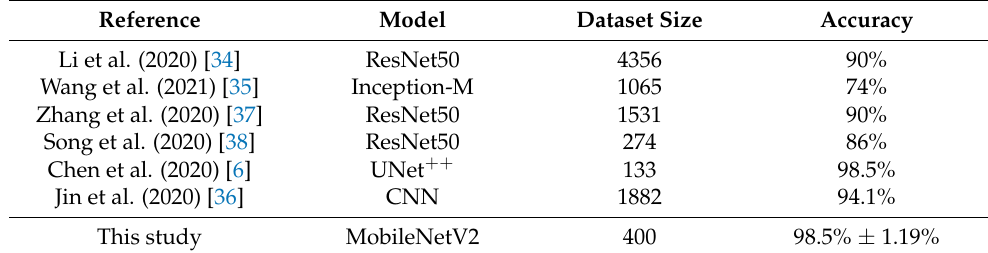
Table 5. Comparison between previous studies found in the literature and our present study.